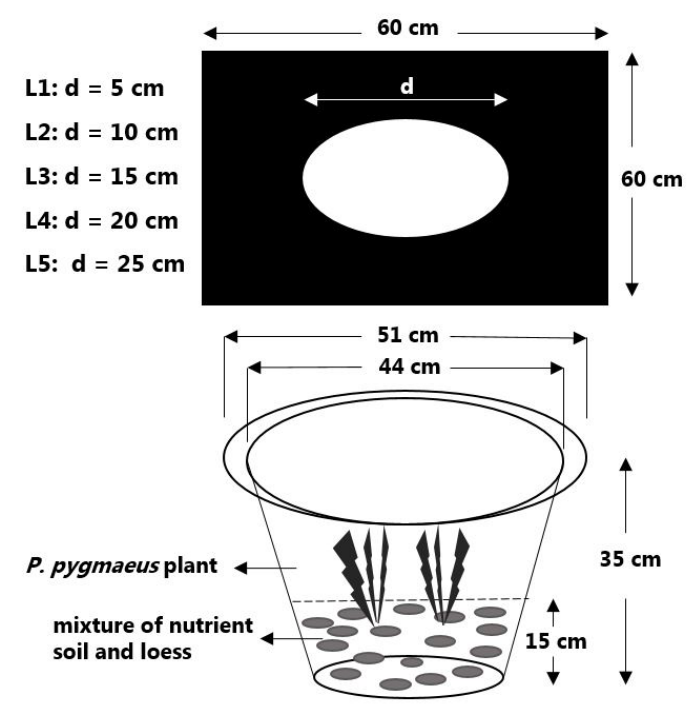
Figure 5. Experiment design and set-up. This drawing was obtained from Huang et al. [22]. One week after confirming the plants’ survival, two-color plates were used to cover the containers on 11 March 2016. The sampling and measurement were started on 15 April 2016, and then the next 11 samplings were conducted around every 25 days until Decem- ber 2016. At each survey time, three pots of each treatment were randomly selected for direct measurement. The specific dates of the 12 investigation times in 2016 are 15 April, 9 May, 3 June, 27 June, 21 July, 12 August, 5 September, 23 September, 17 October, 10 November, 2 December, and 26 December. The specific sampling dates were equal to 36 d, 60 d, 85 d, 109 d, 133 d, 155 d, 179 d, 197 d, 221 d, 245 d, 267 d, and 291 d after the first day of light treatment, respectively. During light treatment, a sunny and cloudless day was regularly selected each month to record the light intensity every half hour between 9:00 and 16:00 o’clock by a TES-1332A digital illuminance meter (TES Electrical Electronic Corp., Taipei). Three pots of each treat- ment were randomly selected to measure the light intensity. During measurement, the probe was set between the aperture of the cover plate and the canopy of the plant. When the value of the illuminance meter remained stable for more than three seconds, the value was recorded. 4.3. Growth Measurement